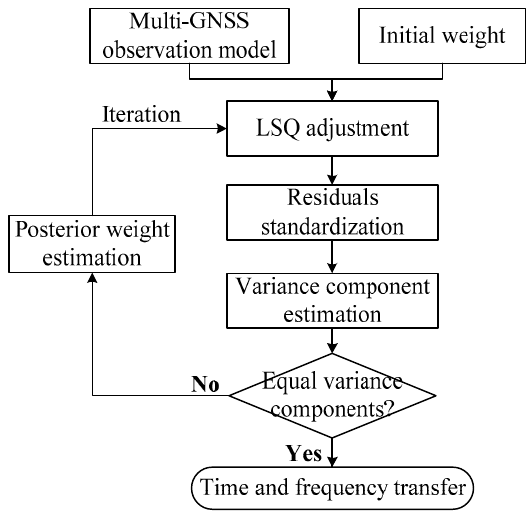
Figure 1. Primary implementation procedure using robust Helmert variance component estimation (RVCE) for time and frequency transfer.